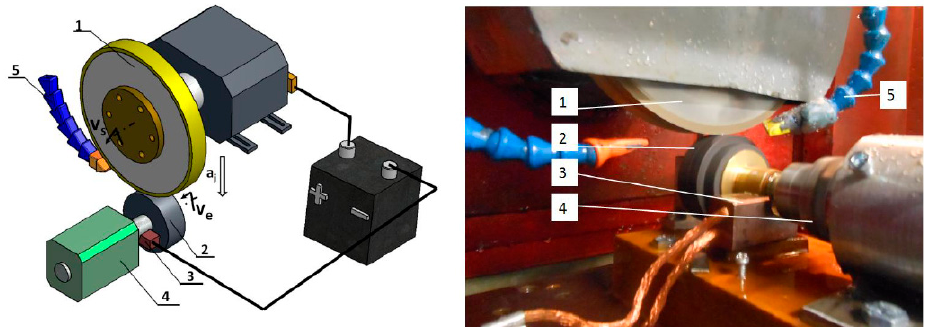
Figure 3. Diagram and view of the system for electrodischarge dressing of superhard grinding wheels with a rotating electrode: 1—grinding wheel, 2—rotating electrode, 3—copper graphite brush supplying voltage from the generator to the electrode, 4—pneumatic motor, 5—dielectric supply nozzles.